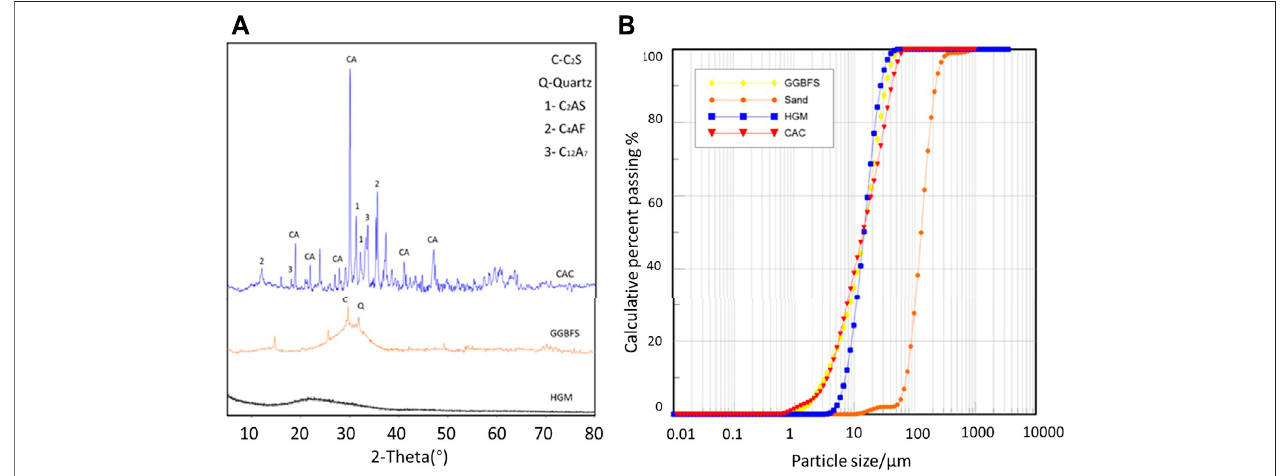
FIGURE 2 | (A) XRD patterns and (B) Particle size distributions of cementitious materials and HGM.